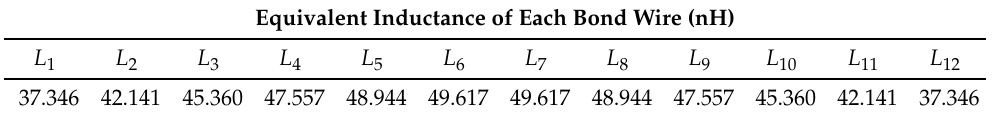
Table 2. Equivalent inductance of each bond wire.